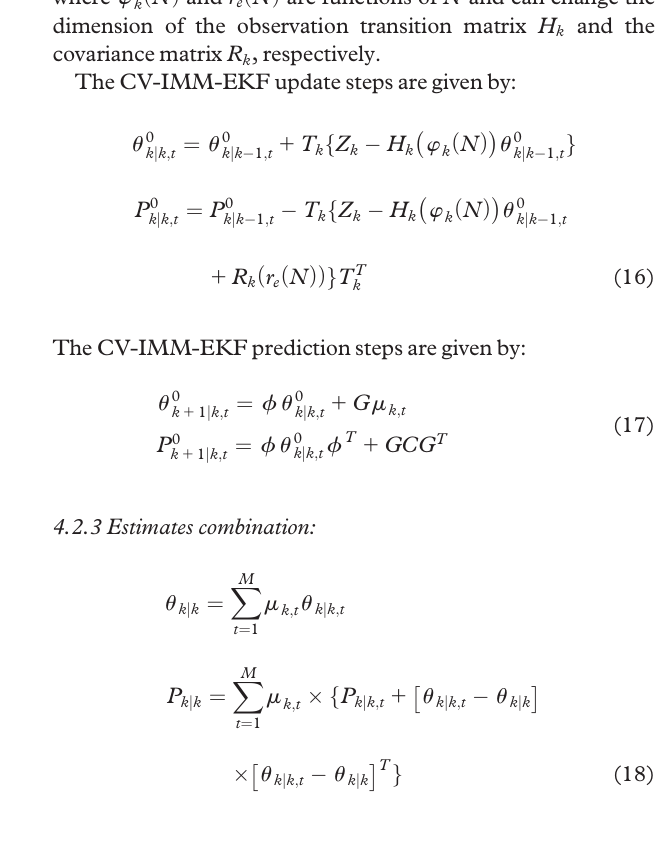
ffiffiffiffiffiffiffiffiffiffiffiffiffiffiffi p 0 : 99 = 2